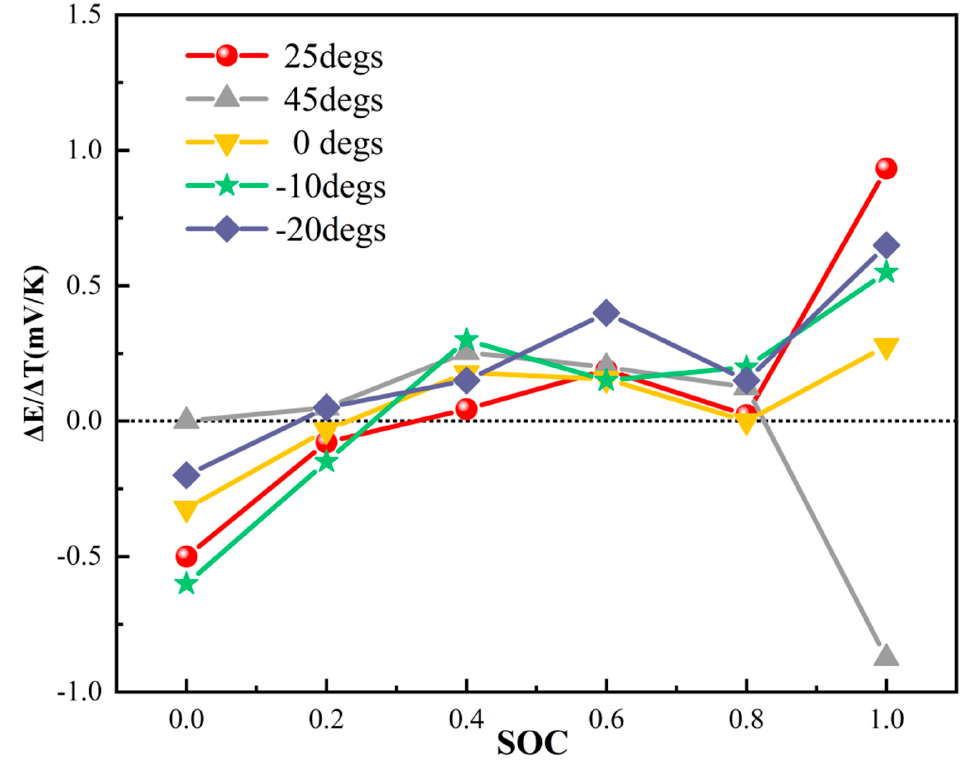
Figure 4. Entropy thermal coefficient test results of large-size battery monomer.